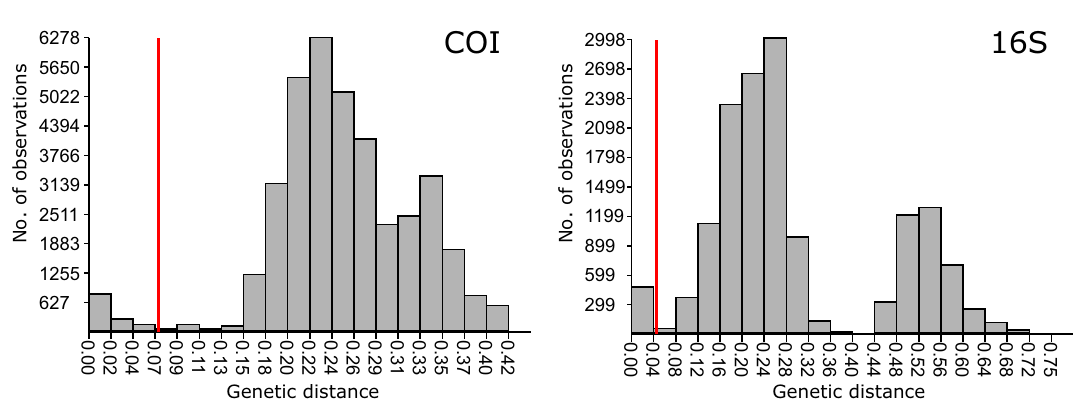
Figure 4. Histogram of COI and 16S K2P distances between specimens. The red line indicates the threshold distance above which specimens are considered to belong to different species, according to ASAP. Misidentified